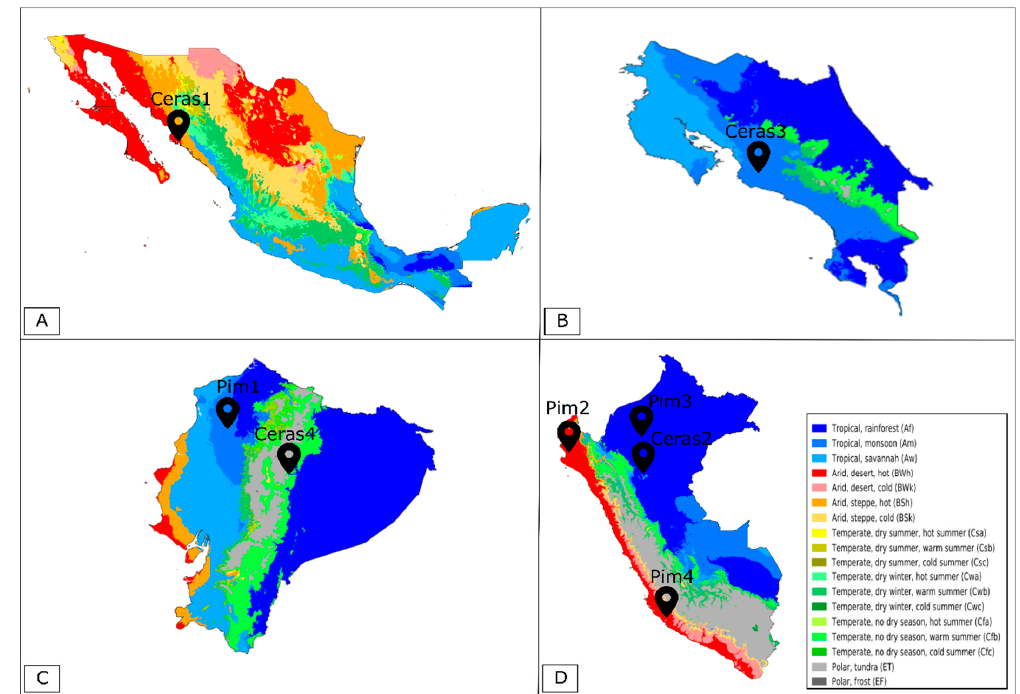
Figure 1. Köppen-Geiger climate classification map of Mexico ( A ), Costa Rica ( B ), Ecuador ( C ) and Peru ( D ) with the collection sites of the eight tomato accessions used in this study marked. Adapted from Beck et al. (2018) [39].